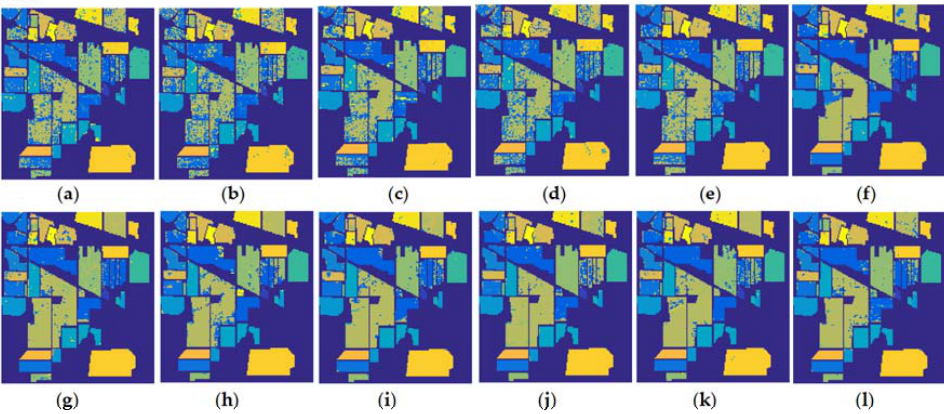
Figure 6. Results in Indian Pines dataset (40 training samples per class): ( a ) K-SVM (spectral; OA = 77.14); ( b ) SMLR (spectral; OA = 67.05); ( c ) K-SMLR (spectral; OA = 75.84); ( d ) ESMLR (spectral; OA = 69.14); ( e ) K-ESMLR (spectral; OA = 77.22); ( f ) K-SVM (EMPAs; OA = 89.15); ( g ) SMLR (EMAPs; OA = 89.65); ( h ) K-SMLR (EMAPs; OA=89.82); ( i ) ESMLR (EMAPs; OA = 90.44); ( j ) K-ESMLR (EMAPs; OA = 90.44); ( k ) SMLR (proposed linear MFL; OA = 90.79); ( l ) ESMLR (proposed linear MFL; OA=91.78).